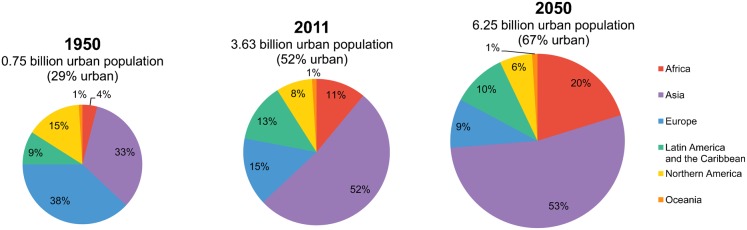
Urban Population Growth by RegionData from the United Nations.2